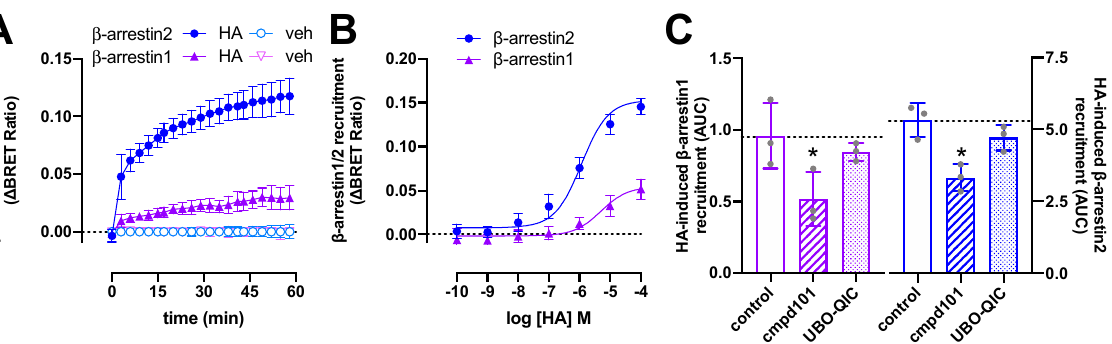
Figure 2. Histamine (HA)-induced β -arrestin1/2 recruitment to H 1 R. BRET measurements in HEK293T cells transiently co-expressing H 1 R-Rluc8 (0.5 µg plasmid/dish) in combination with β -arrestin1-eYFP or β -arrestin2-mVenus (4.0 µg plasmid/dish) in real time upon stimulation with 10 µM histamine ( A ) or after 1-h stimulation with increasing concentrations histamine ( B ). Data are shown as mean ± SD from at least four independent experiments performed in triplicate. Area under the curve (AUC) of 1-h BRET traces in response to 10 µM histamine following 30-min pretreatment of the cells with vehicle (control), 3 µM cmpd101, or 1 µM UBO-QIC. AUC of the BRET experiments are presented as mean ± SD from three independent experiments performed in triplicate, with scatter plots (gray dots) showing the individual AUC values ( C ). Statistical differences ( p < 0.05) compared to vehicle-pretreated (i.e., control) cells were determined using one-way ANOVA with Dunnett’s multiple comparison test and are indicated by an asterisk.